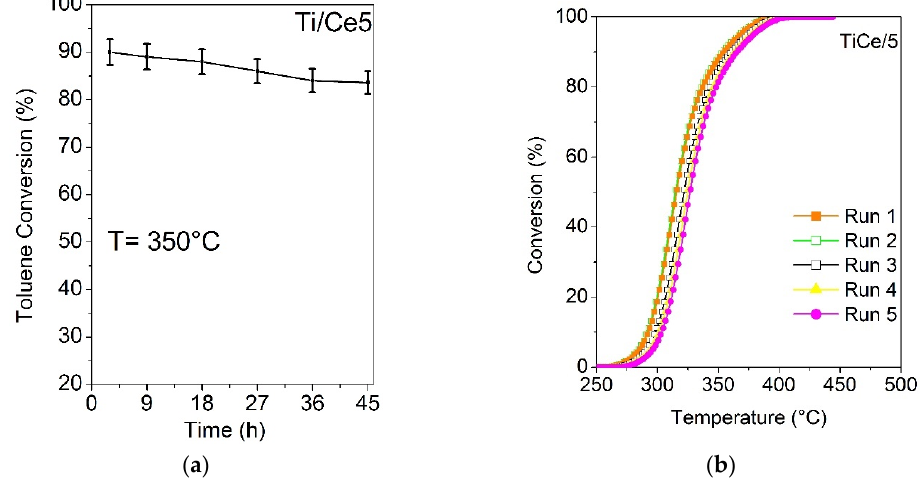
Figure 9. ( a ) Toluene thermocatalytic oxidation; ( b ) solar photocatalytic oxidation at room temperature after 2 h of irradiation; and ( c ) the photothermo-catalytic oxidation on the investigated samples.